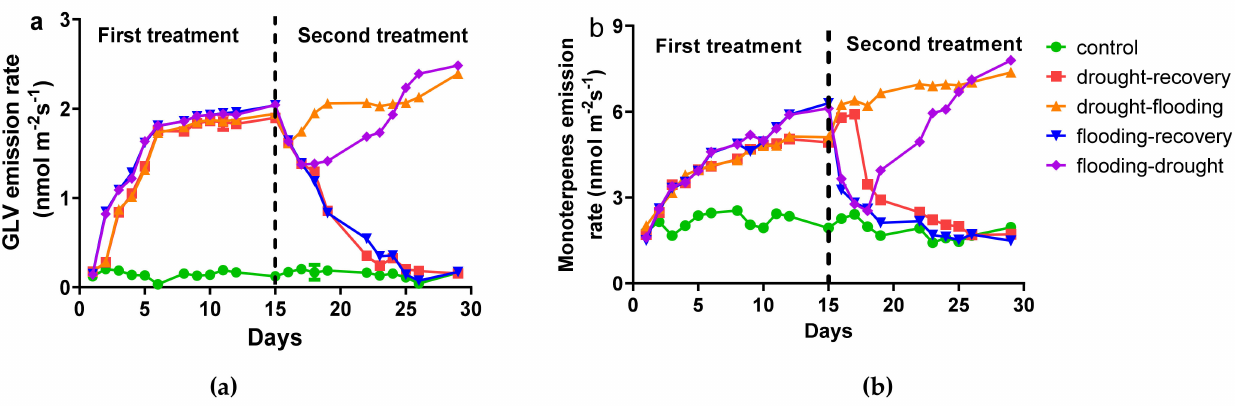
Figure 3. The emission rate of green leaf volatile compounds (GLV) ( a ) and monoterpenes ( b ) from O. basilicum plants under different stress